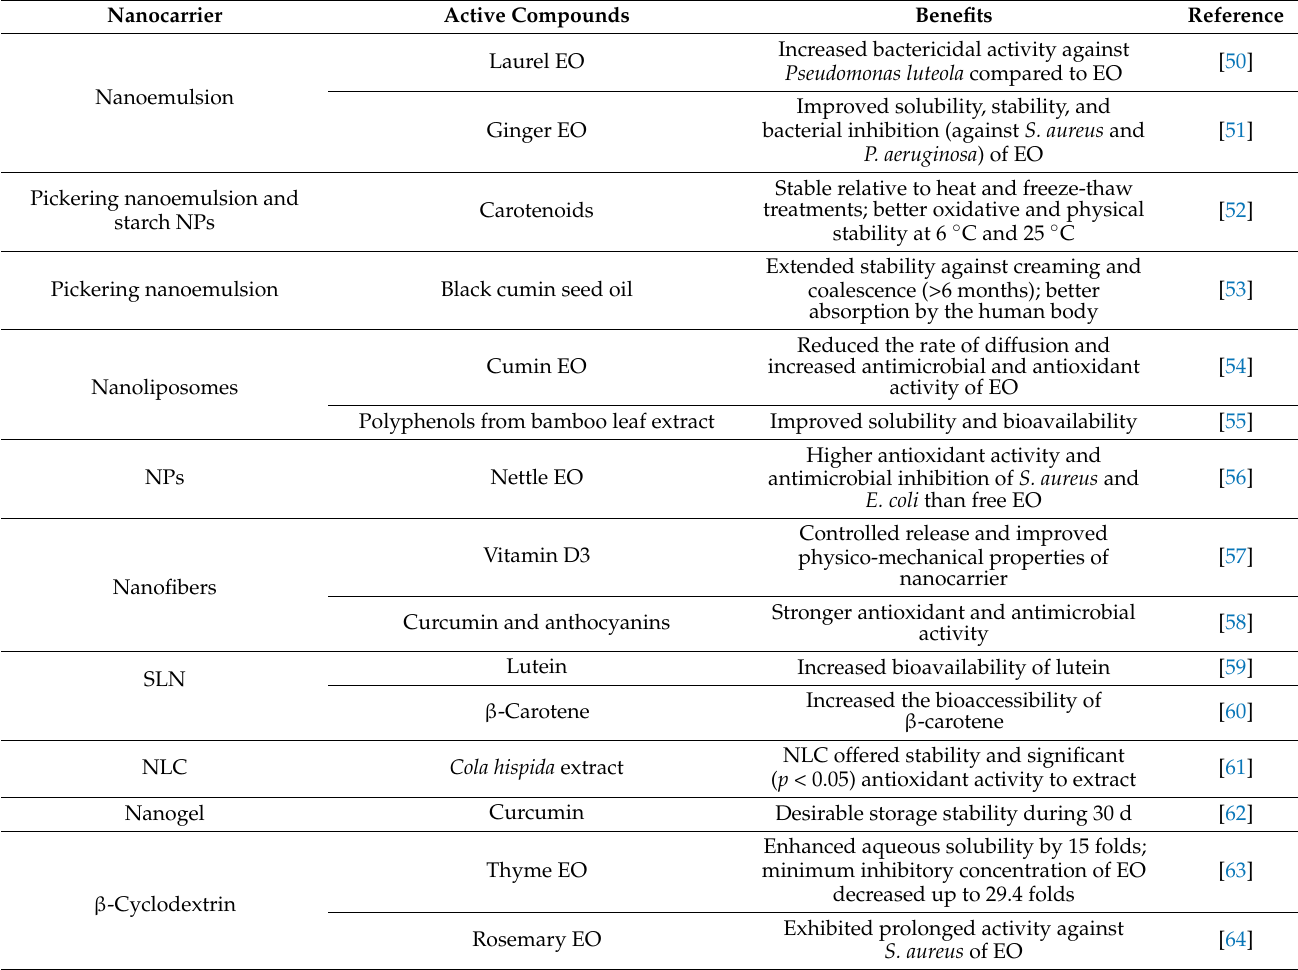
Table 1. Recent examples of active compounds loaded